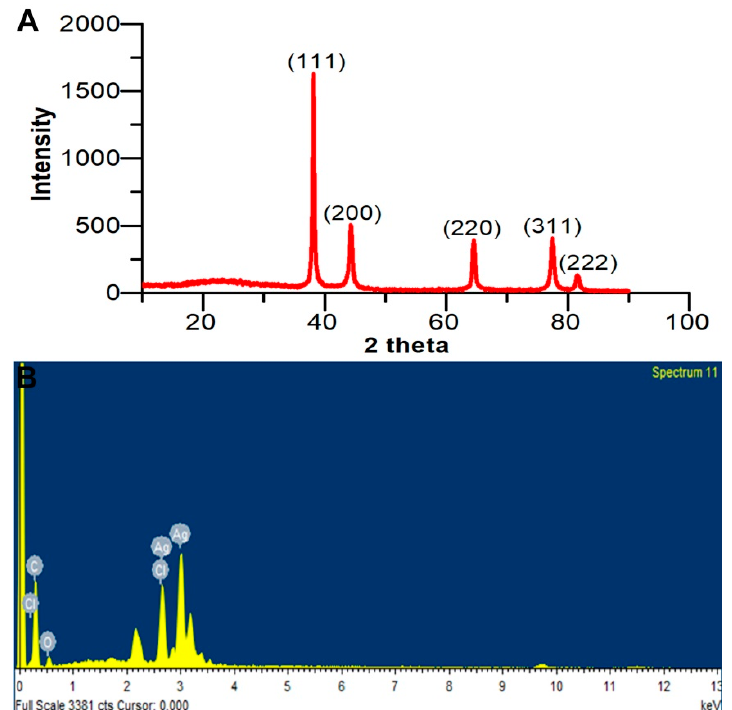
Figure 3. ( A ) X-ray powder diffraction (XRD) profile of the biogenic AgNPs. ( B ) Energy Dispersive X-Ray Analysis (EDX) spectrum of the biosynthesized AgNPs with their corresponding strong Ag signal at 3 keV.